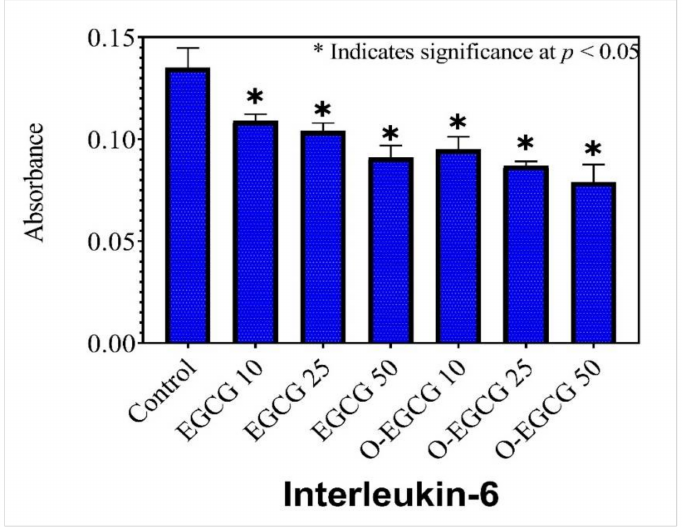
Figure 6. The effect of EGCG and O-EGCG on IL-6 production in HCT-116 cells. (* indicates significance at p < 0.05).